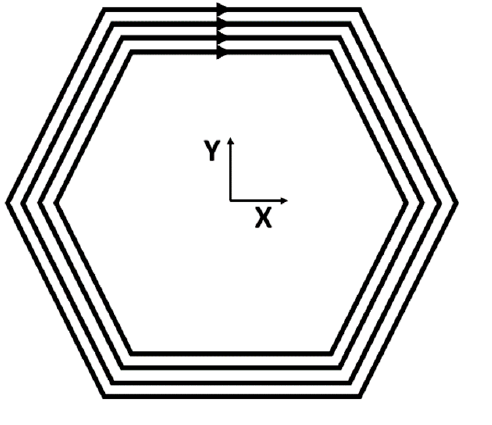
thickness of the component, ( b ) The samples embedded in the resin for metallographic observation extracted in two parallel planes (XY- and ZX-oriented).